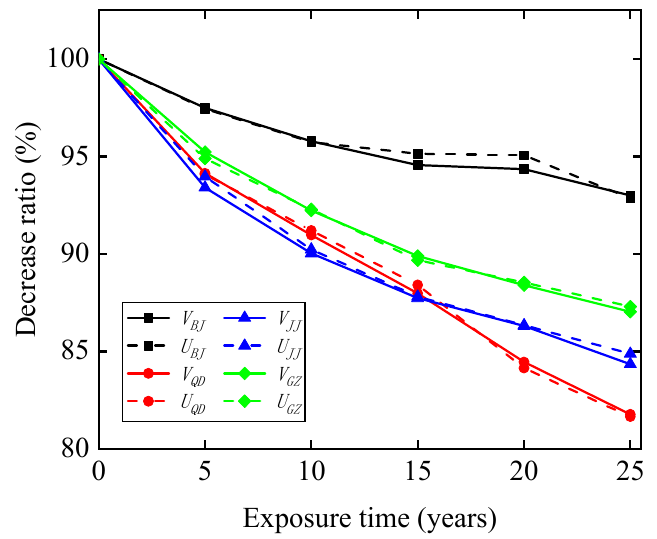
Figure 21. Decay curves of the wind-resistant performance of the transmission tower.